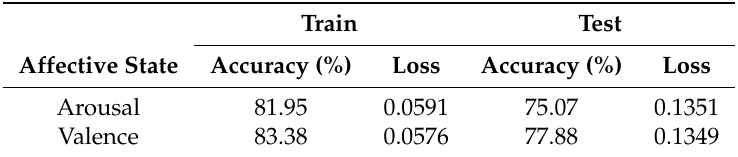
Table 9. Classification system results with GSR, ECG, and EEG combined demonstrates that the inclusion of EEG reduces the